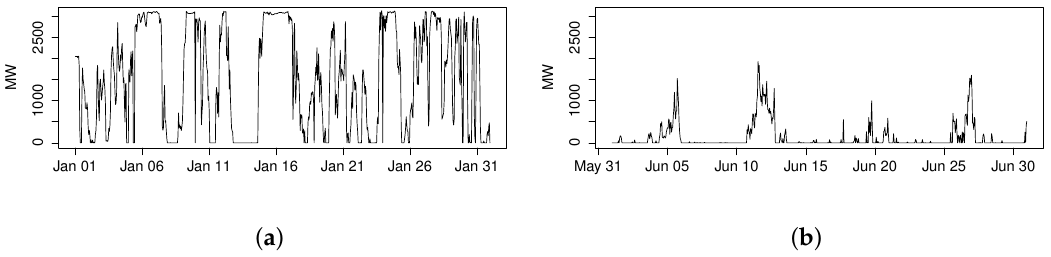
Figure 4. Wind electricity generation of the wind farm in Shinan, South Korea. ( a ) wind electricity on January 2011; ( b ) wind electricity on June 2010.